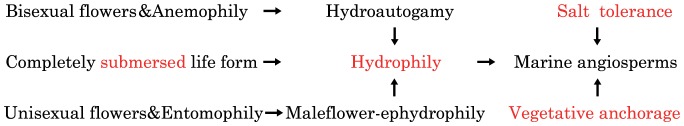
The correlations of life form, sexual system, pollination mode and marine angiosperms.Red words represent the four requisites of marine angiosperms.